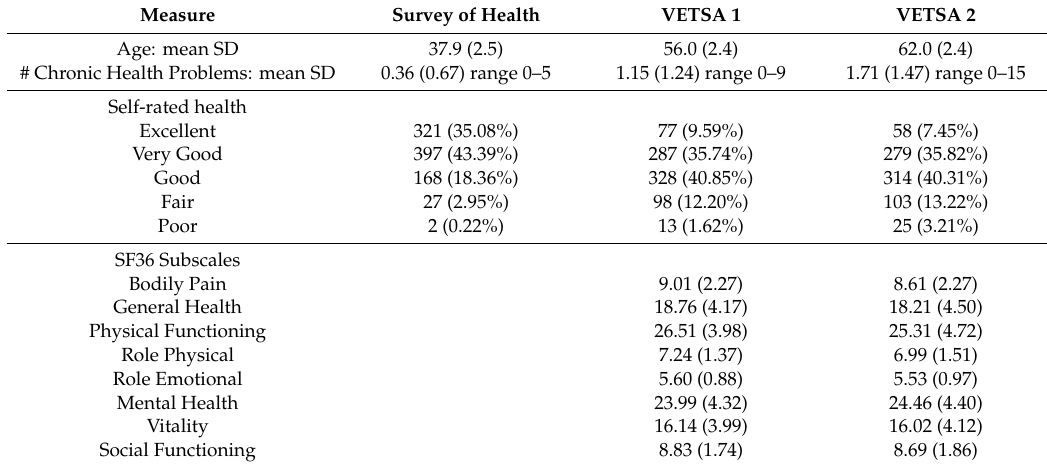
Table 1. Descriptive Statistics.